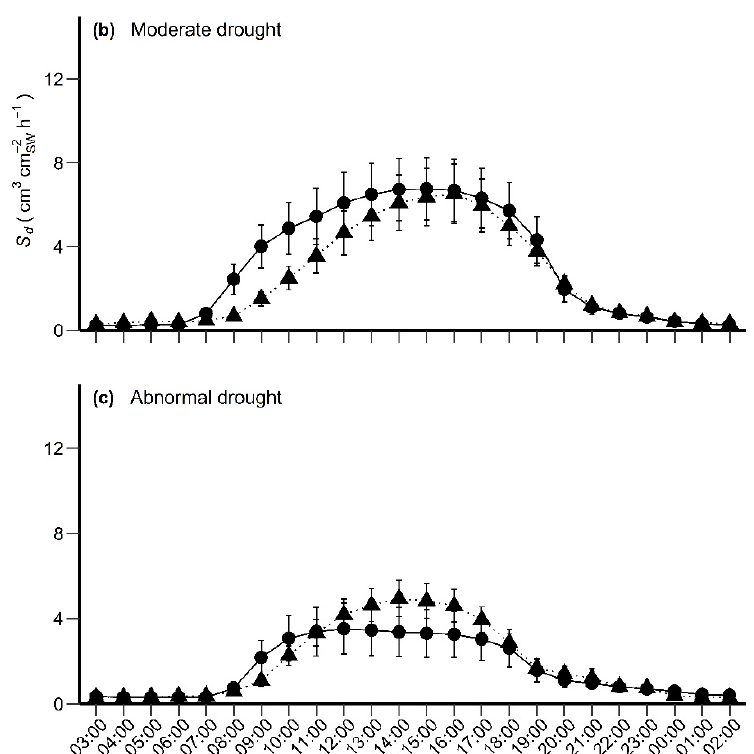
Figure 4. Typical diurnal changes of S d for the post oaks (OAK) and redcedars (ERC). Data are hourly values averaged over the growing season (from May to October) ( a ), during the moderate drought in 2018 (14–28 July) ( b ), and during the abnormal drought (dry conditions that could turn into drought or are recovering from drought but are not yet back to normal) in 2017 (1–24 September) ( c ). Although species differed in diurnal sap flow patterns, the relationship between daily S d and daily VPD of both post oak and redcedar was similar. Both species were characterized by a bell- shaped response with peaks of S d around 1.0–1.2 kPa and substantially decreased S d (~25% of maximum) when VPD was below 0.2 kPa or over 2.4 kPa (Figure 5).